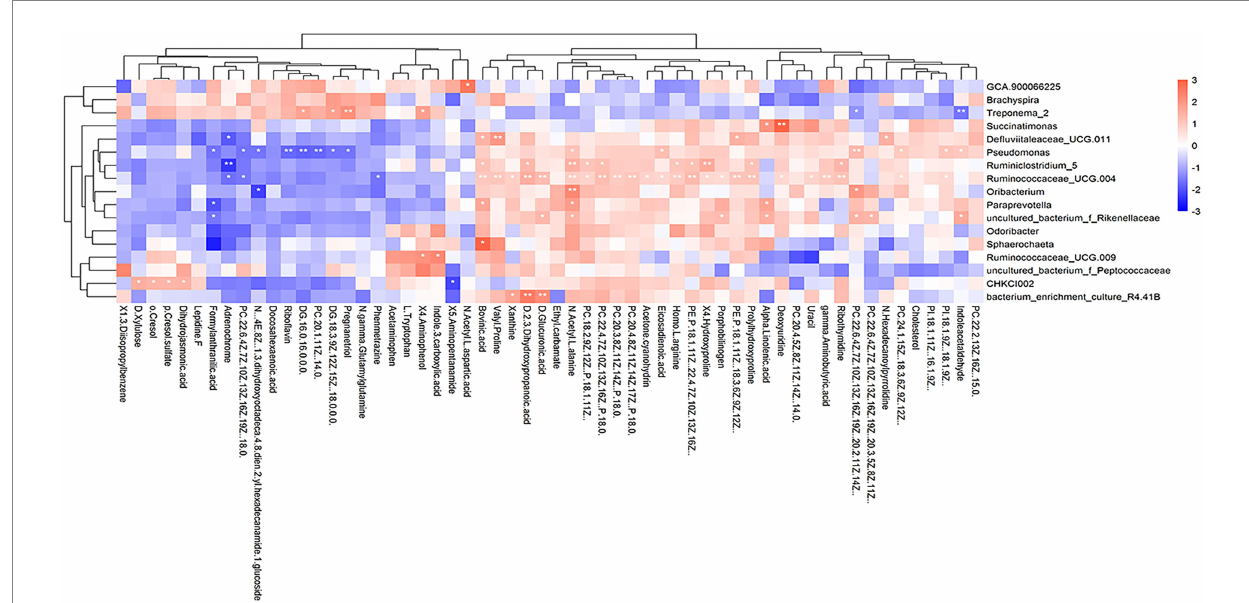
FIGURE 7 Heatmap depicting correlations between differential serum metabolites and differential species of cecal microbiota in Qiandongnan Xiaoxiang Chickens at 160 ± 3 days of age ( n = 21). * p < 0.05, ** p < 0.01, *** p < 0.001 were calculated using the Spearman’s rank correlation